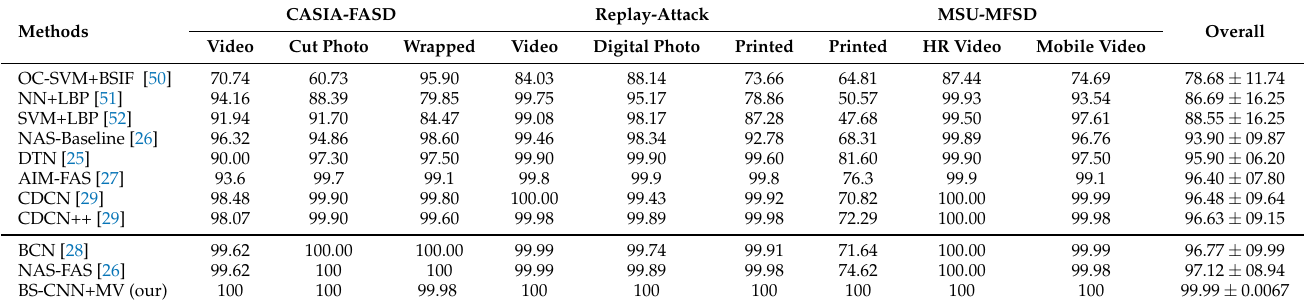
Table 6. AUC (%) of the model cross-type testing on CASIA-FASD, Replay-Attack, and